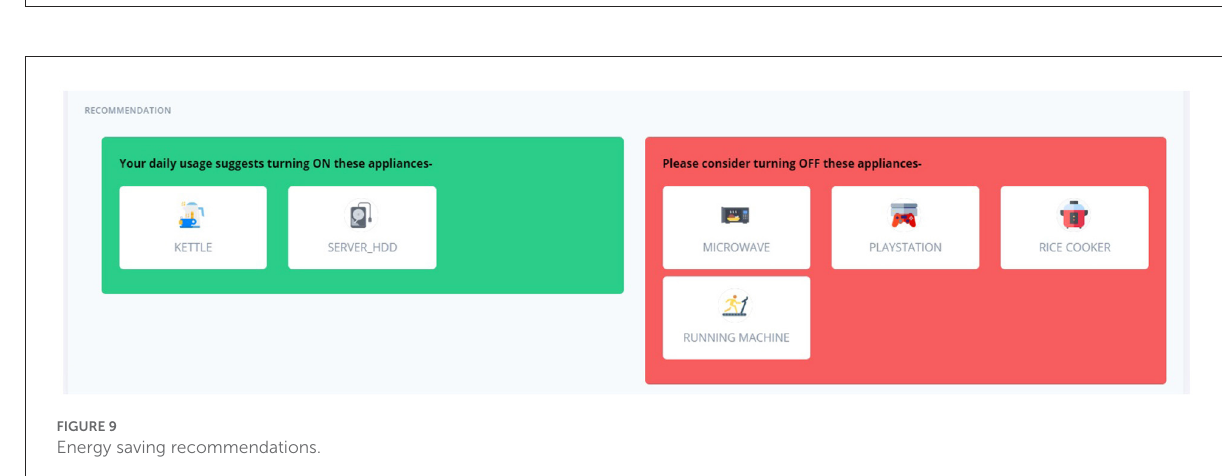
FIGURE9 Energy saving recommendations.